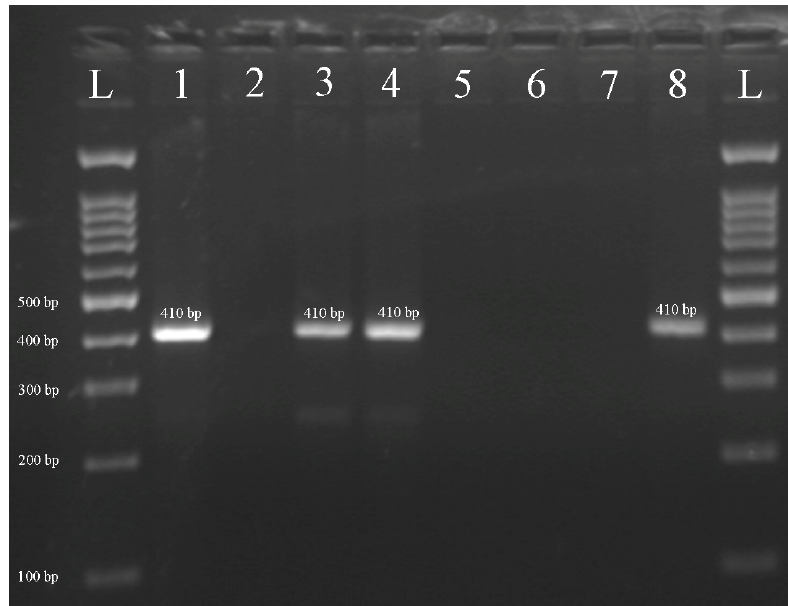
Figure 6. Amplification products of S14-410 marker linked to loci of Lr54 + Lr37 leaf and stem rust resistance genes. ( 1 ) Aegilops kotschyi (UUS k S k ); ( 2 ) triticale ‘Sekundo’(AABBRR); ( 3 ) double 40T +